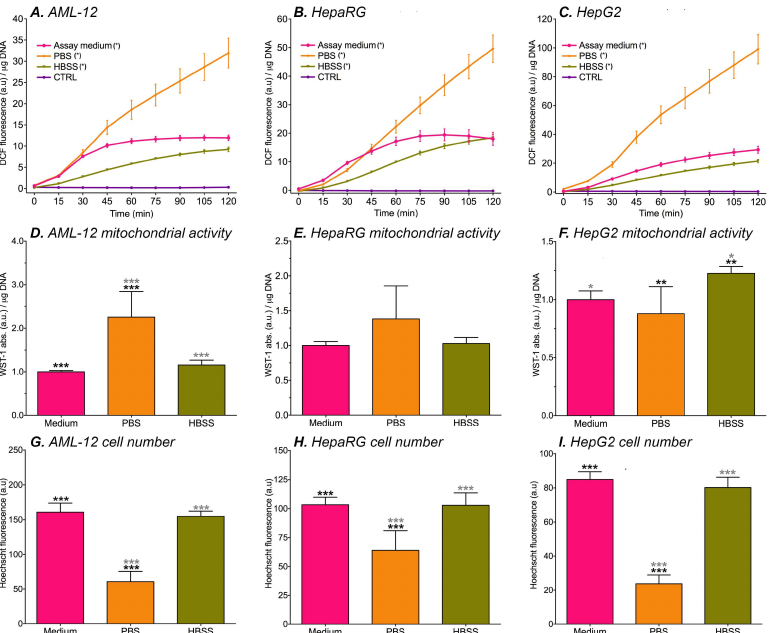
Figure 2. The influence of prolonged physiological buffer exposure on DCF fluorescence (indicating basal oxidant formation, A – C ), WST-1 absorption (indicating mitochondrial activity, D – F ), and Hoechst fluorescence (indicating cell number, G – I ). The data are presented as mean ± SD (n = 6 per group). (*) = ∆ flu (fluorescence at t = 120 − t = 0) significantly different vs. 0 µ M ( A – C , p < 0.05 one-way ANOVA, Dunnett’s post hoc test). * = p < 0.05, ** = p < 0.01, *** = p < 0.001 ( D – I , one-way ANOVA, Tukey’s post hoc test). The assay medium was composed of non-supplemented and phenol red-lacking WE medium containing 25 mM HEPES. Abbreviations: DCF = 2 (cid:48) ,7 (cid:48) -dichlorofluorescein; a.u. = arbitrary units; WST-1 = water soluble